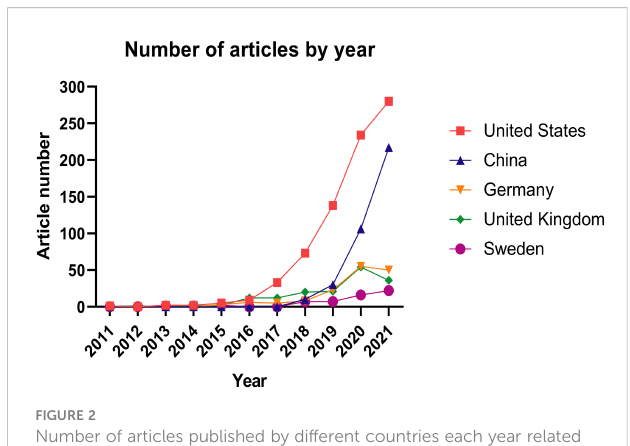
FIGURE 2 Number of articles published by different countries each year related to single-cell sequencing on immune cells. As shown in the icon, the United States is represented by the red line, China is represented by the blue line, Germany is represented by the yellow line, the United Kingdom is represented by the green line, and Sweden is represented by the purple